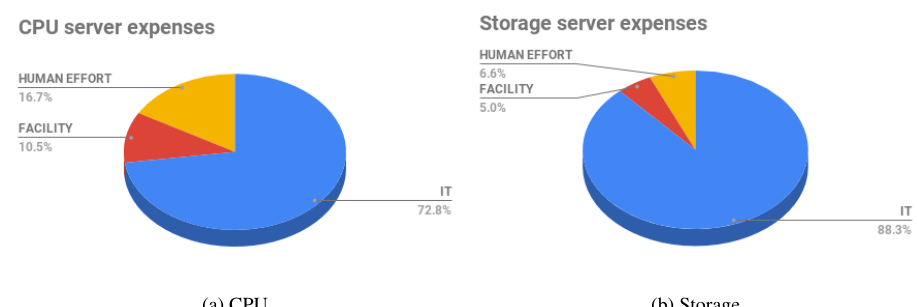
Figure 3. Atomic